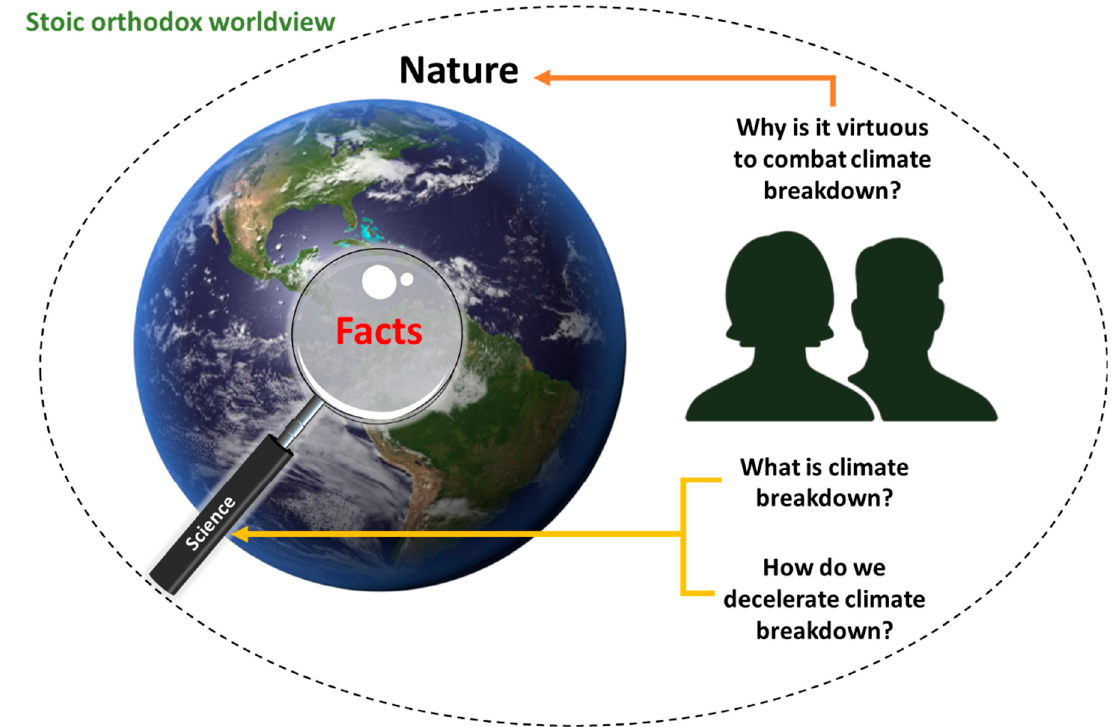
Figure 1. Stoic orthodox theology applied to environmental ethics.